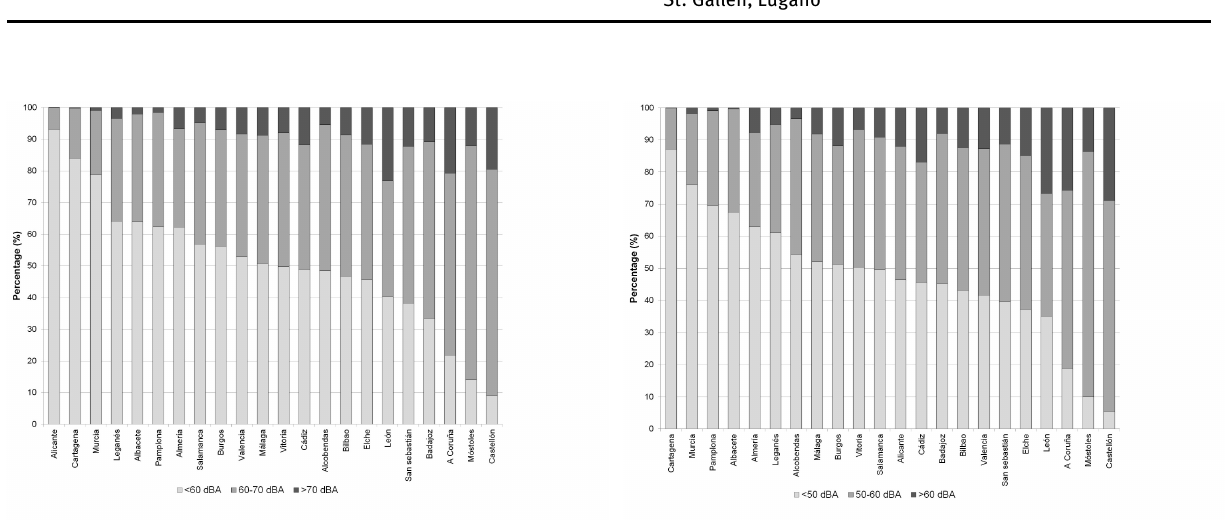
Figure 2: Percentage of people affected by traflc noise ( L n ) in the Spanish agglomerations, arranged in ascending order of proportion of people affected by L n > 50